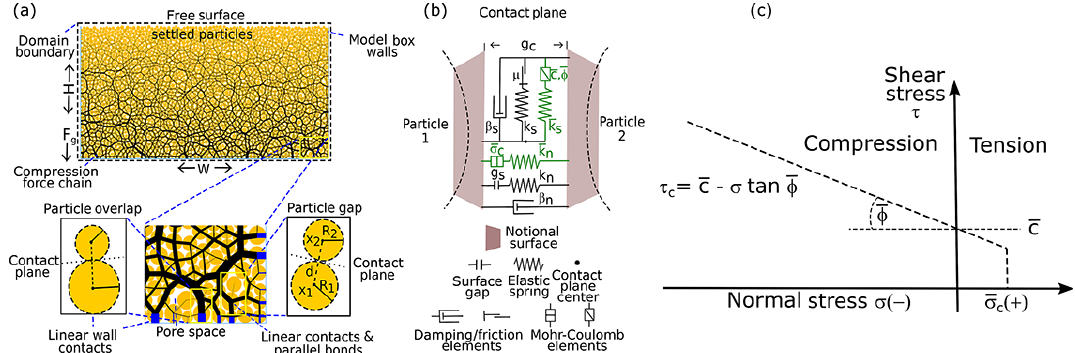
Figure A1. Schematic description of 2-D DEM modelling with PFC2D v5. (a) Inter-particle and particle-wall force chains developed after gravity settling of an assembly of balls in a box of dimension H × W . The close-ups below show the pore space, contact planes and nomenclature. Particles, although undeformable, are allowed to overlap slightly or have a small gap g c . In both cases, linear contacts and optional parallel bonds are active. These bonds act additionally to the linear contacts. (b) Close-up of the notional and contact planes with all elements necessary for the physical definition of the contact and bond interactions. (c) Failure criterion for parallel bonds. Compression in this study is considered as